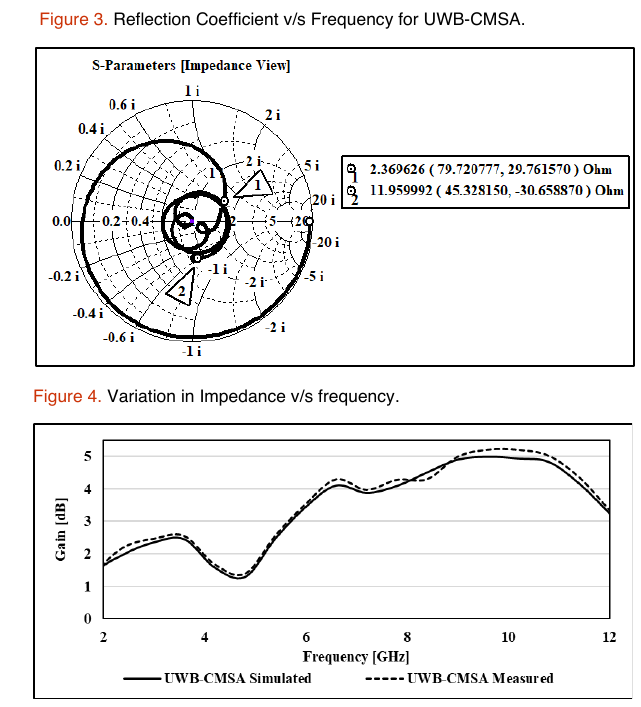
Figure 5. Variation in maximum gain v/s